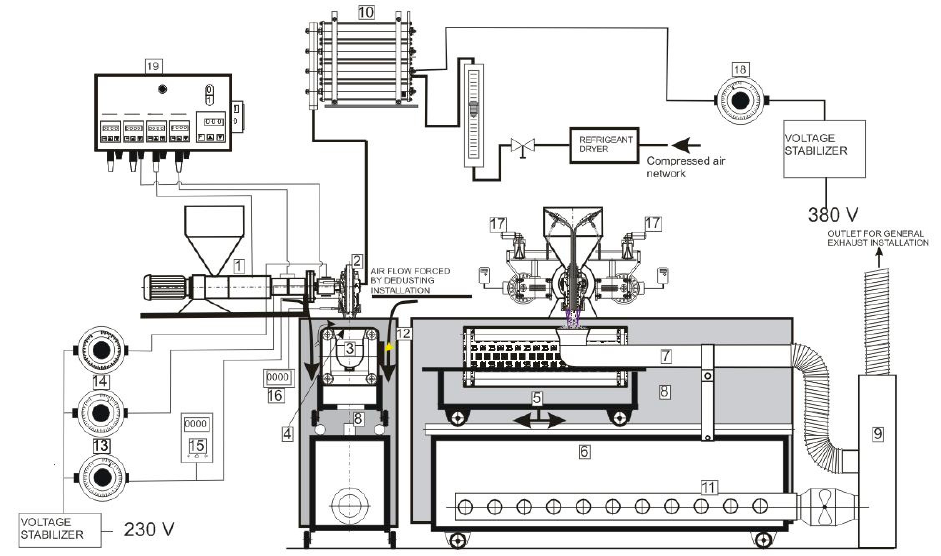
Figure 1. Diagram of the melt-blowing setup for the fabrication of multifunctional polymeric composites. 1—polymer extruder, 2—fiber-forming head, 3—fiber-attracting nozzle, 4—fiber- embedding mesh, 5—carriage shifting the mesh perpendicular to the extruder axis, 6—trolley